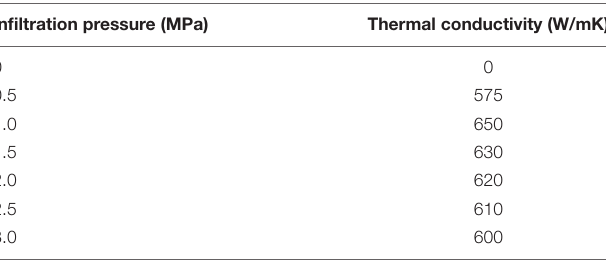
TABLE 5 | Infiltration pressure v/s thermal conductivity (at 750 ◦ C) (Zhang et al., 2014). Infiltration pressure (MPa)